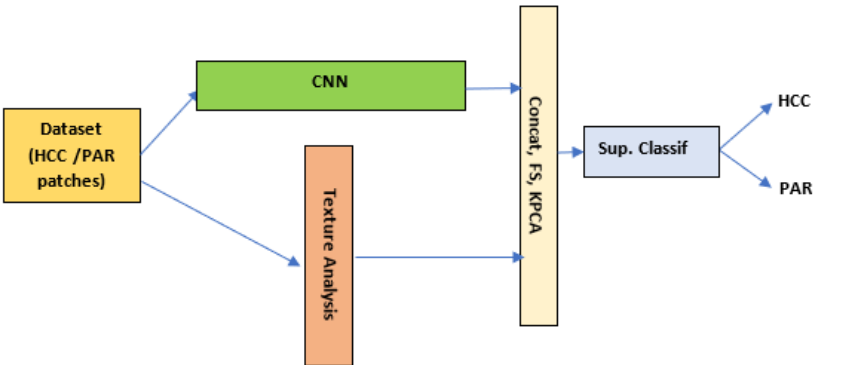
Figure 3. The graphical representation of the methodology for classifier-level fusion: (1) the images in the dataset are simultaneously provided to the CNN and to the texture analysis module; (2) then, the two resulting feature vectors are concatenated, feature selection methods or KPCA being even- tually applied before or after the concatenation procedure; and (3) the fused feature vector is then provided at the entrance of a powerful conventional supervised